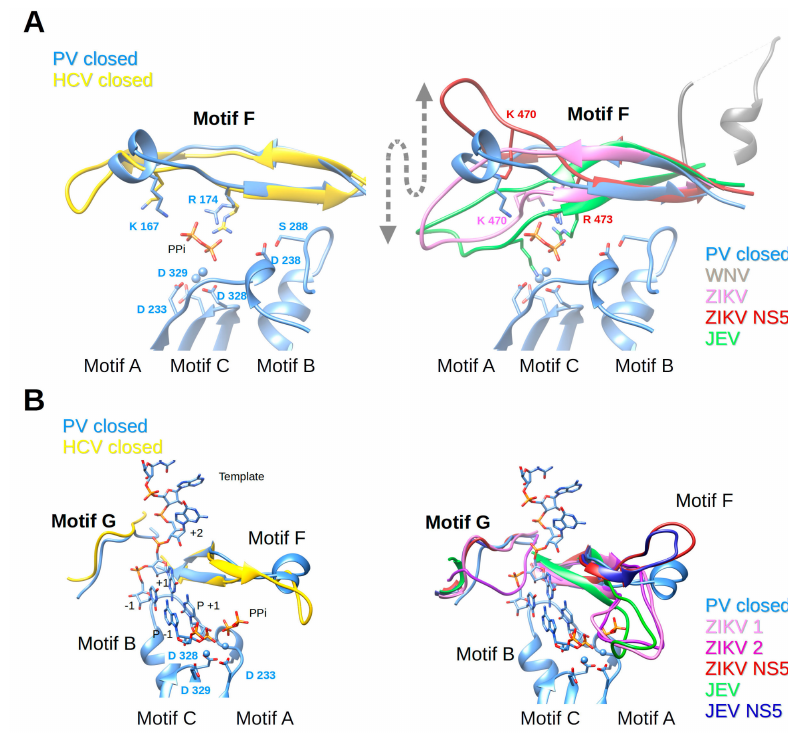
Figure 6. Motifs F and G of PV RdRp and HCV RdRp complexes (left panels) in comparison to motif conformations of Flavivirus RdRps (right panels). ( A ) Motif F; left panel: ribbon representation of PV RdRp (PV closed, PDB ID: 3OL7, blue) in complex with the template and product represented in sticks (colored according to atom type: C, blue; O, red; P, orange), and two Mg 2+ ions as blue spheres, just after the incorporation of P+1. The formed pyrophosphate (PPi) is still present at the catalytic site. Only motif F is shown of HCV RdRp (HCV closed, see explanations in the legend of Figure 5B, PDB ID: 4WTA, gold). Selected amino acid side chains are shown and colored according to atom type. Right panel: PV closed (blue) as in the left panel superimposed to WNV RdRp (PDB ID: 2HFZ, grey, motif F only partial and in helical conformation, 90 ◦ to the catalytic conformation), ZIKV RdRp (PDB ID: 5UOC, orchid), ZIKV NS5 (PDB ID: 5U0B, dark red), JEV RdRp (PDB ID: 4MTP, green). The arrow indicates the significant flexibility of motif F in Flavivirus RdRps. ( B ) Motif G; left panel: as in ( A ), PV RdRp (PV closed, PDB ID: 3OL7, blue) with the template, product, and PPi. Only motifs G and F are shown of HCV RdRp (HCV closed, see explanations in the legend of Figure 5B, PDB ID: 4WTA, gold). Right panel: PV closed (blue) as in the left panel superimposed to ZIKV RdRp (ZIKV 1 and ZIKV 2, chains A and D, respectively, of PDB ID: 5UOC, orchid and purple, respectively), ZIKV NS5 (PDB ID: 5U0B, dark red), JEV RdRp (PDB ID: 4MTP, green, motif G only partial) and JEV NS5 (PDB ID: 4K6M, dark